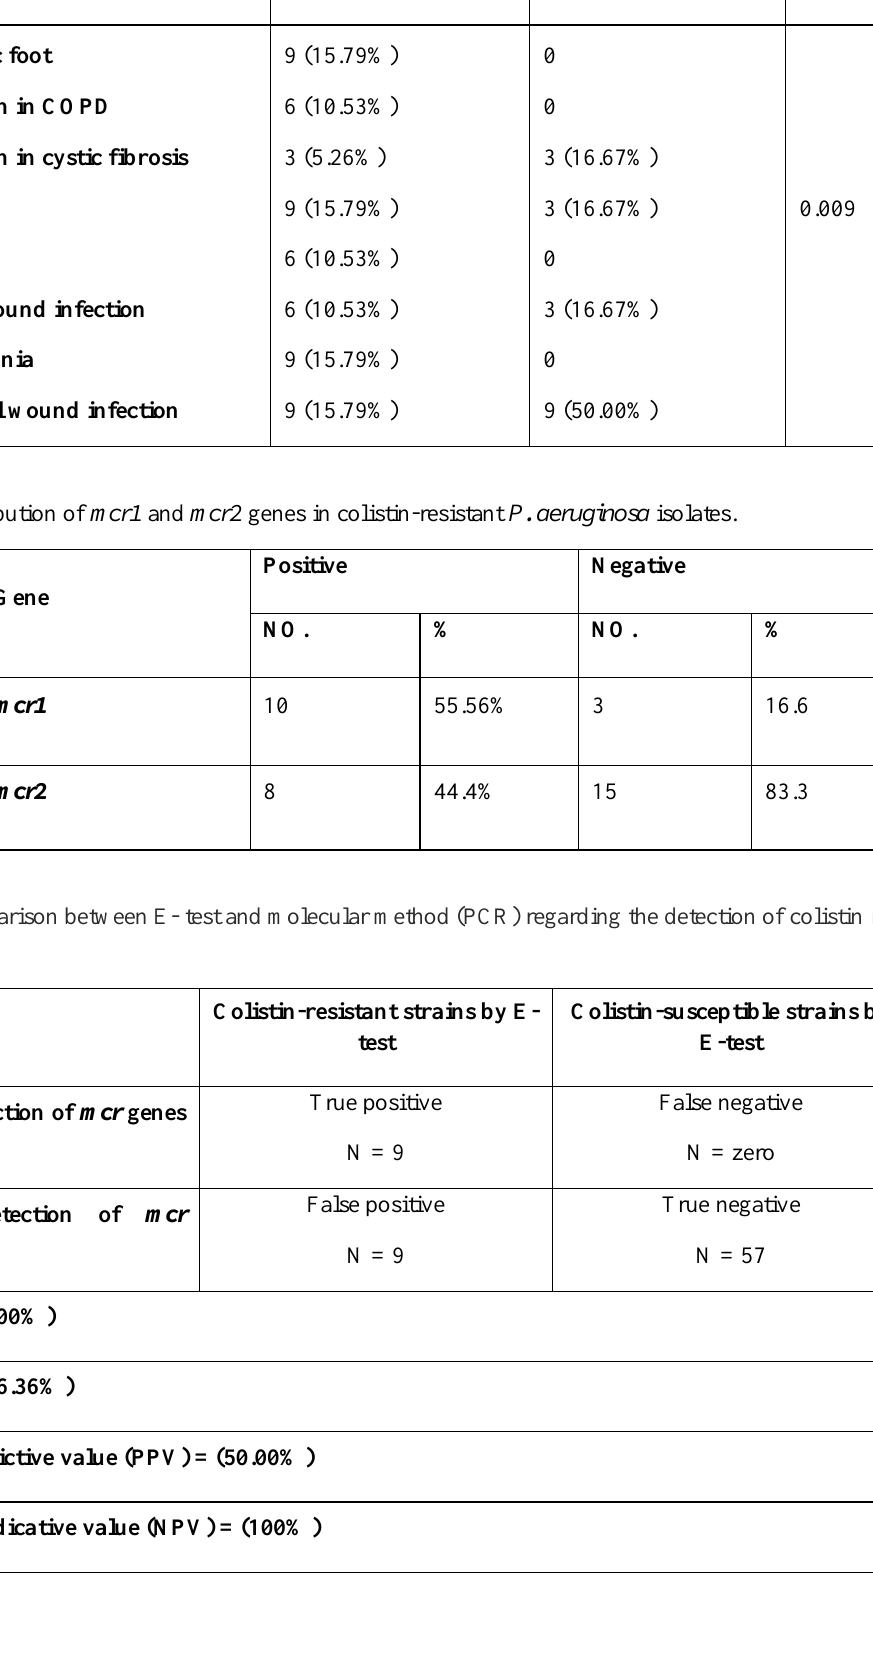
Table 7. Distribution of Colistin-sensitive and Colistin-resistant strains isolated from different types of HAIs Variable